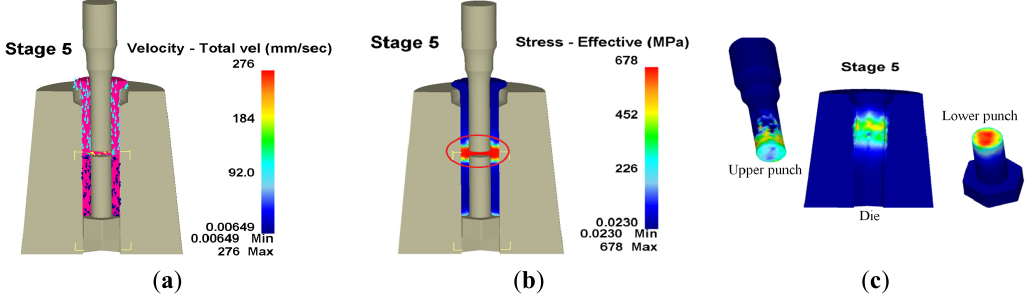
Figure 13. Velocity, effective stress and wear distribution of the fifth stage in 3D. ( a ) Velocity; ( b ) Effective stress; ( c ) Wear.